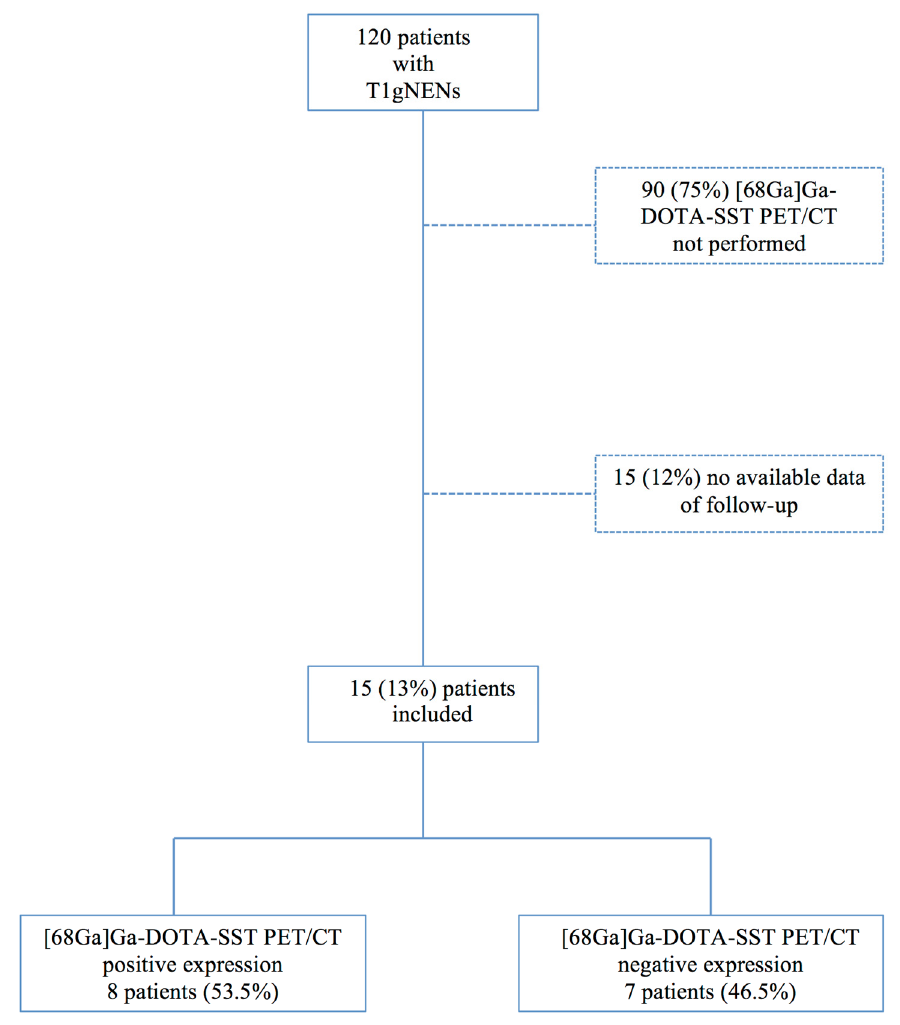
Figure 1. Flow chart of patient selection.